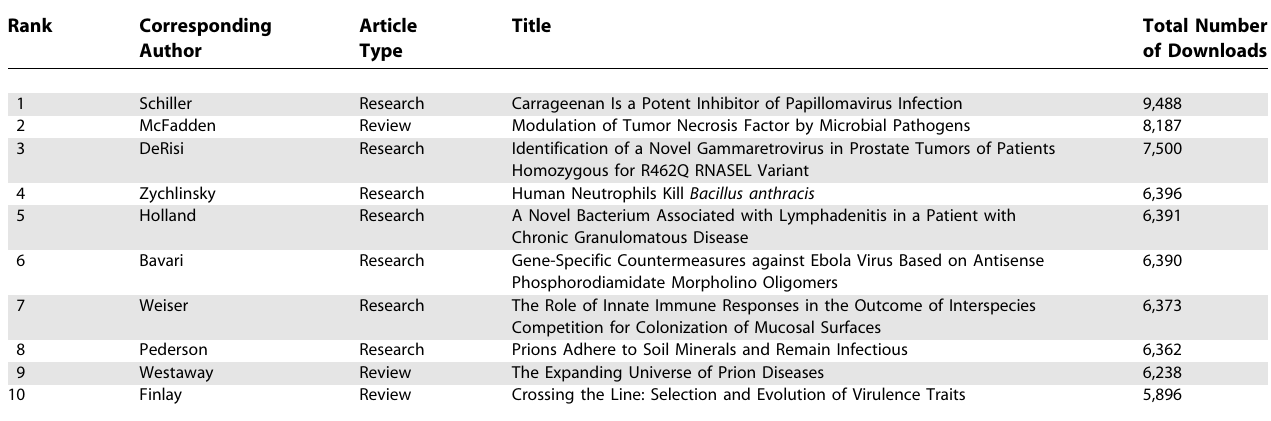
Table 1. Top Ten Downloaded Papers from PLoS Pathogens , September 2005 to July 2007